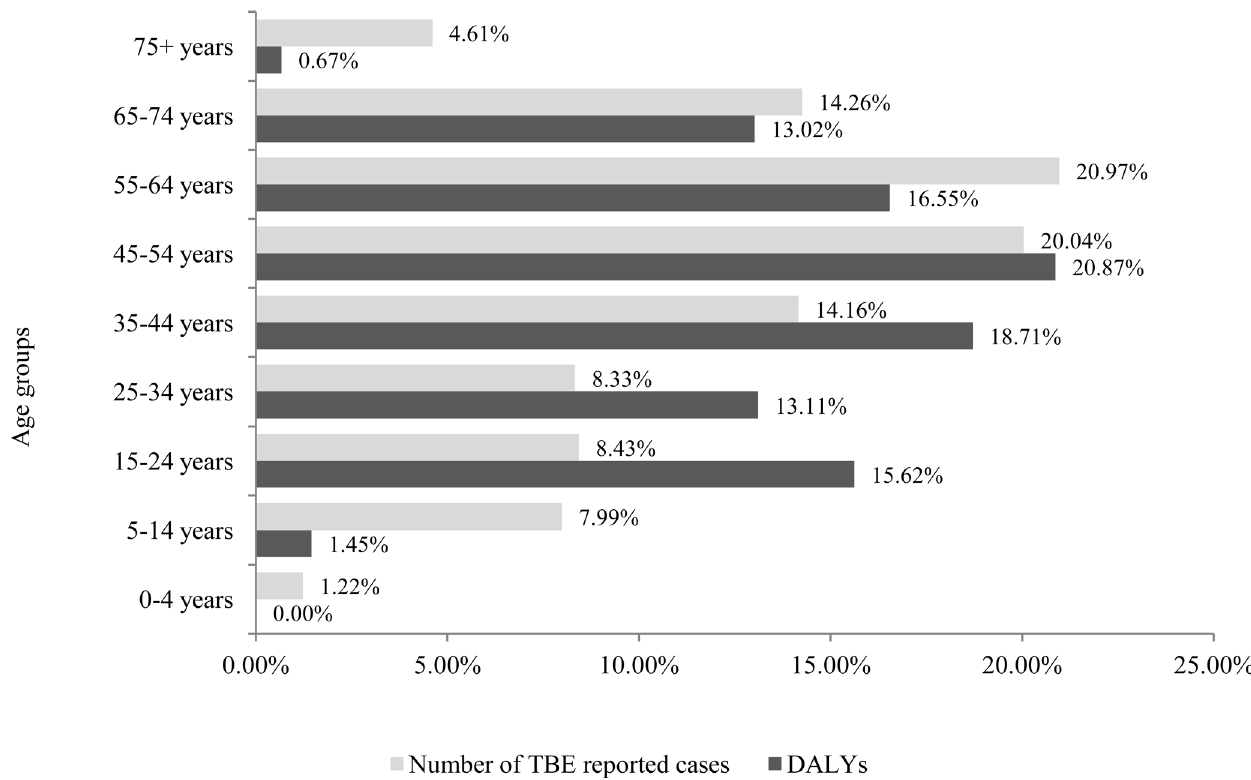
the burden in the prime-aged workers group from 25 to 54 years of age amounts to 53%, fol- lowed by the burden in the youth workers group from 15 – 24 years of age and older workers group from 55 to 64 years (16 – 17%).